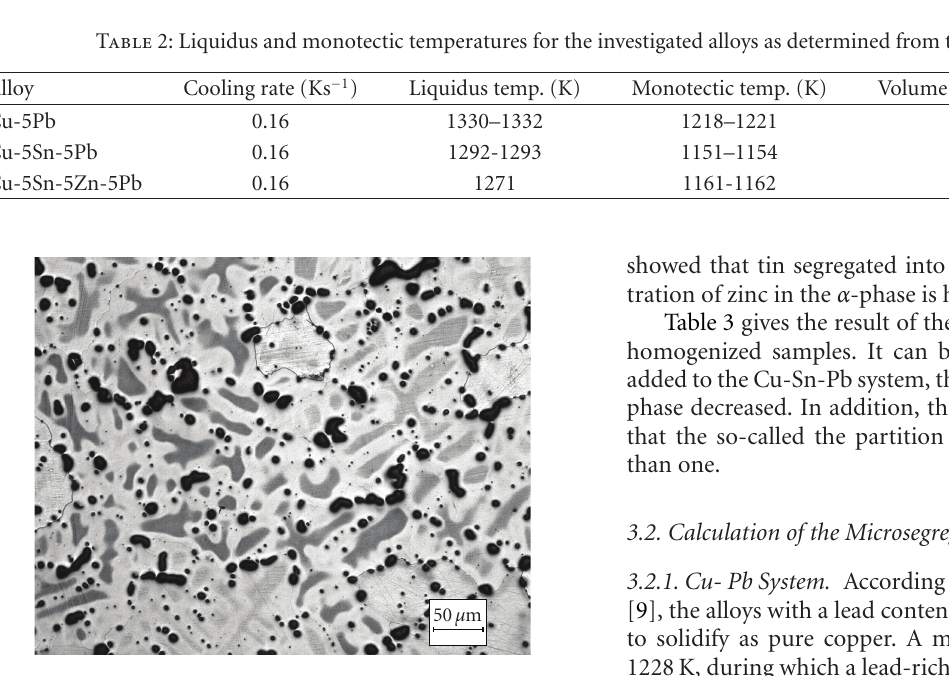
Figure 3: Microstructure of Cu-5Sn-5Pb alloy solidified at a cooling rate of 0.16 Ks − 1 .